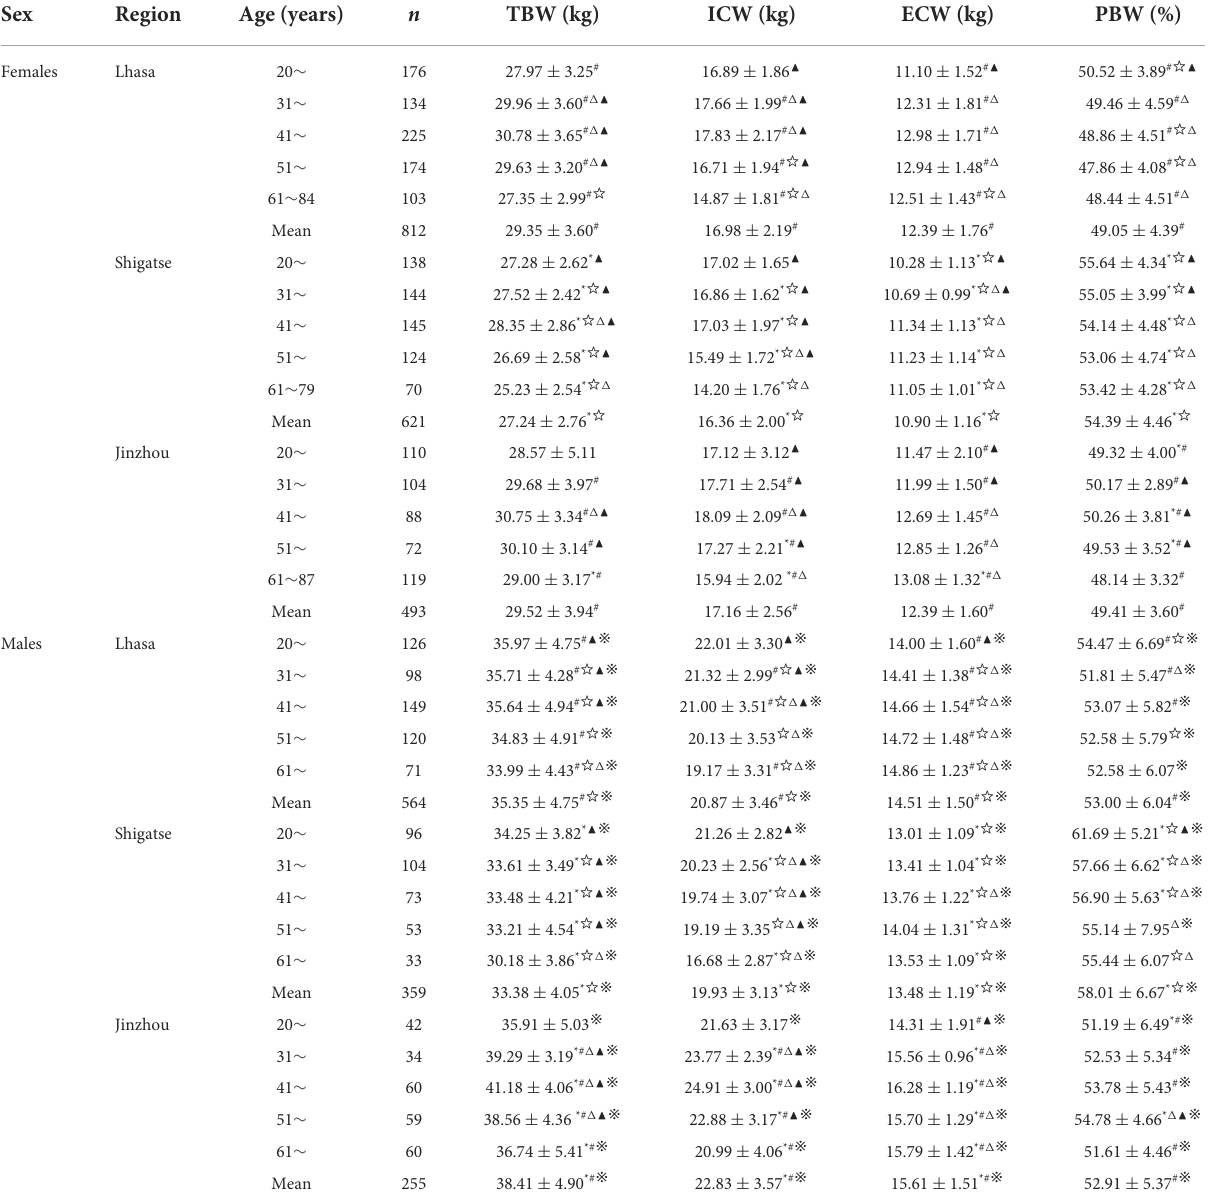
TABLE 5 Sex-specific body composition of water mass as stratified by age and altitude. Sex Region Females